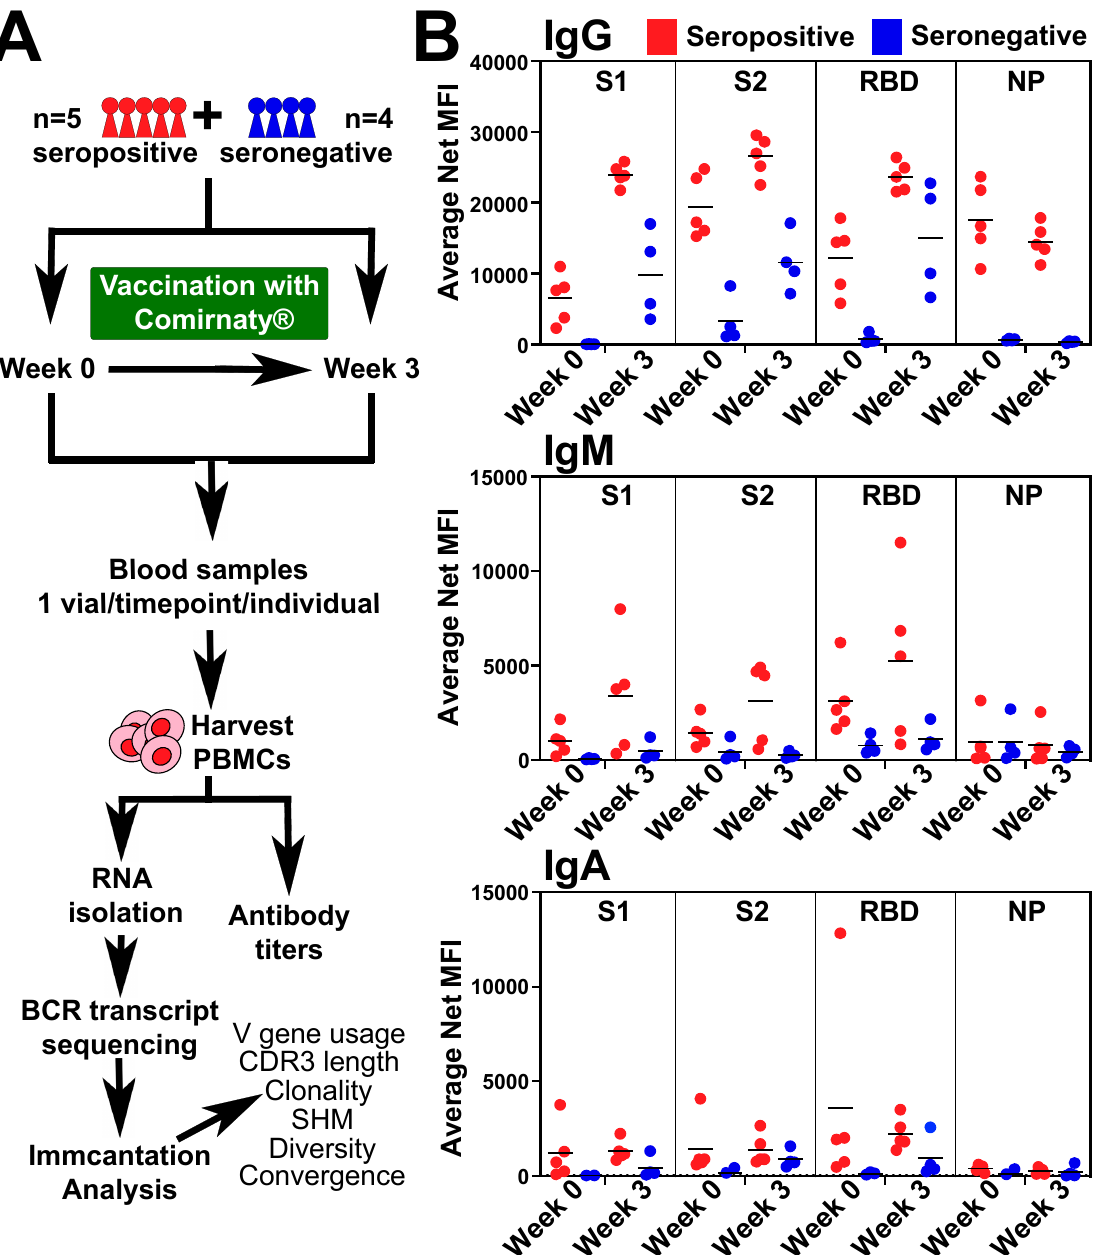
Figure 1. Experimental design and antibody titers in response to vaccination. ( A ) Schematic showing experimental design and details. ( B ) Antibody titers IgG/M/A for SARS-CoV-2 spike 1 protein (S1), spike 2 protein (S2), receptor binding domain (RBD), and nucleocapsid protein (NP) of seropositive (red, n = 5) and seronegative (blue, n = 4) individuals: pre-vaccination (week 0) and 21 days after (week 3) first dose of Comirnaty ® (Pfizer, New York, NY, USA). No significant changes in the distribution of heavy-chain complementarity deter- 3.2. Immunization Did Not Alter the Global BCR Isotype, Variable Gene Usage, or HCDR3 mining region 3 (HCDR3) lengths between seropositive and seronegative at week 0 (Kolmogorov–Smirnov Test; p = 0.9525), or at week 3 (Kolmogorov–Smirnov Test; p = 0.9983) were observed (Figure 2C). Similarly, the distributions of HCDR3 lengths in IgM and IgA were not different between seropositive and seronegative at week 0 or week 3 (Kolmogorov– Smirnov Test; week 0 p = 0.9525; week 3 p = 0.9983 and week 0 p = 0.9983; week 3 p = 0.9983, respectively) (Supplemental Figures S1B and S2B). Therefore, our data suggested